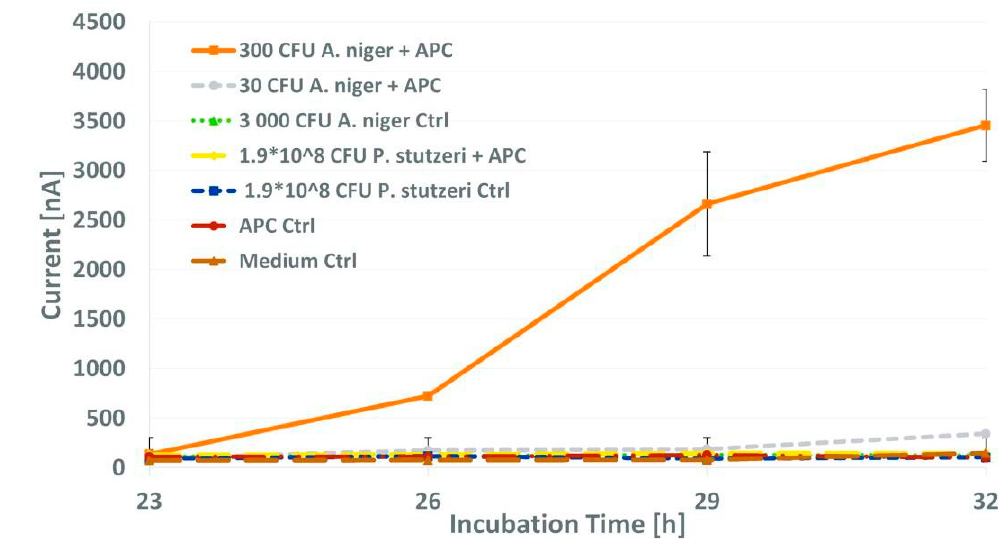
Figure 3. Mean output signals (between 0–250 mV) of different concentrations of Aspergillus niger spores (3000 CFU, 300 CFU and 30 CFU) and the bacterium Pseudomonas stutzeri (1.9 × 10 8 CFU) including 1 mM